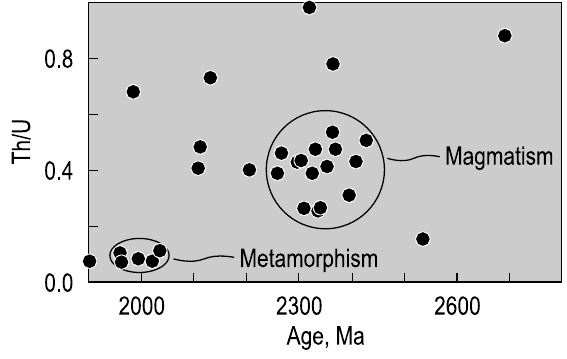
Fig. 4–AgeversusTh/Uratioofzircon, sample1, granodioritegneiss. Th/U ratios near 0.4 are considered magmatic and ratios < 0 . 1 meta-